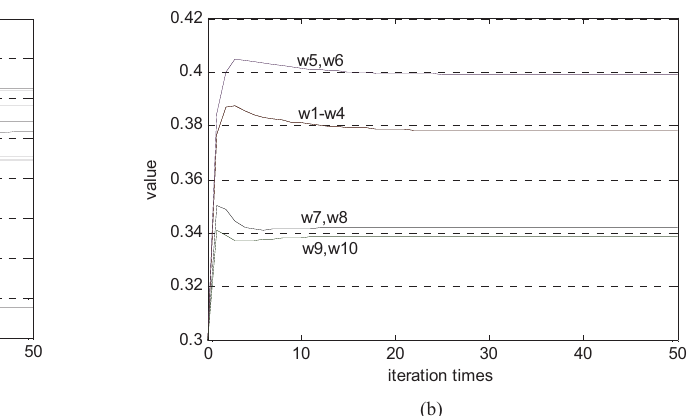
Fig. 6 Parts of input weights learning results of model (a) L1 model (b) B1 model